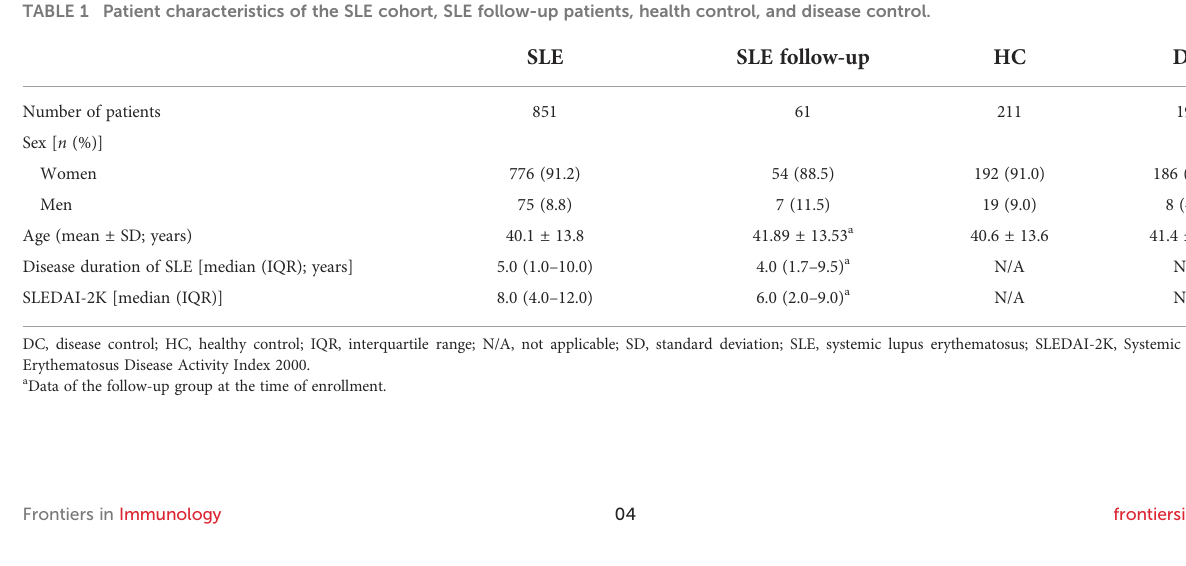
TABLE 1 Patient characteristics of the SLE cohort, SLE follow-up patients, health control, and disease control. Number of